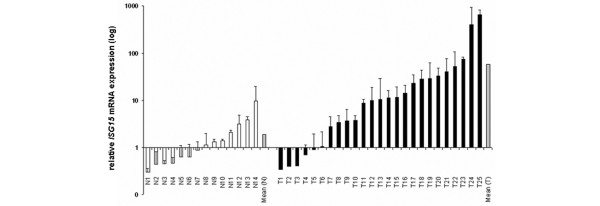
Upregulation of ISG15 mRNA in primary breast cancer. A collection of paraffin-embedded breast carcinomas (T; n = 25) and normal breast tissues (N; n = 14) was analysed for ISG15 expression by semiquantative real-time PCR. ISG15 was strongly upregulated at the transcript level in the tumourous tissues compared with the normal breast tissues.